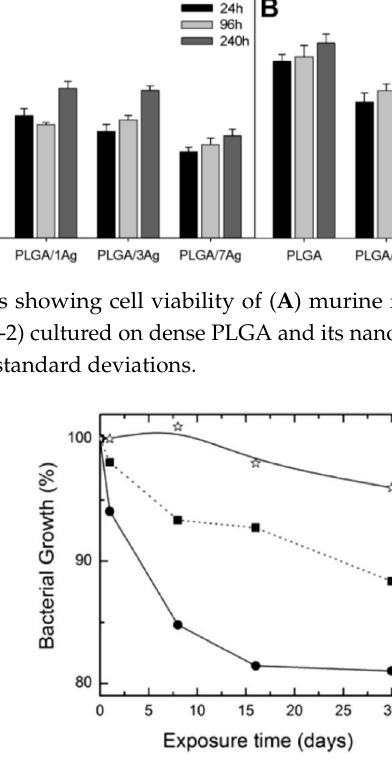
Figure 18. Bacterial growth vs. exposure time profiles of neat PLGA (star), PLGA / 1 wt% AgNPs (square), and PLGA / 3 wt% AgNPs (circle). Reproduced with permission from [170], Copyright Wiley, 2013.